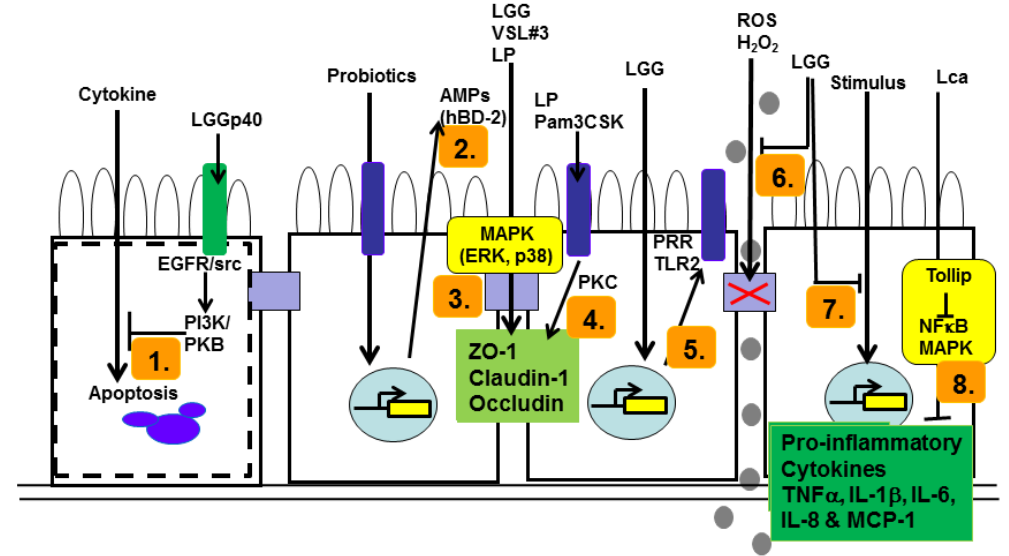
Figure 1. Probiotic modulation of intestinal epithelial cell signaling pathways Probiotic-mediated modulation of epithelial cell responses via activation or suppression of distinct signaling pathways is species ‐ dependent. Mechanisms of modulation are presented above for a range of species of Bifidobacteria, Lactobacilli, Streptococcus, VSL#3 mixture and the yeast S. cerevisiae , indicated in the luminal space above the square epithelial cells; additionally, LGG, L. rhamnosus strain GG; LGGp40, LGG secreted p40 protein; LP, L. plantarum ; Lca, L. casei . Mechanisms are indicated by numbers 1–8 in orange boxes: 1. Anti-apoptotic, 2. Antimicrobial defence, 3. Reinforcement of tight junction (TJ), 4. Reinforcement of TJ (gene expression & translocation to TJ), 5. Pathogen sensing, 6. Protection against TJ damage, 7. & 8. Suppression of inflammatory cytokines. Arrowed lines are activatory, blunted lines are suppressive/inbibitory. Light blue boxes between epithelial cells are representative of tight junctions. Dark blue boxes represent PRRs, predominantly TLR2. Dark green box on apical surface is an, as yet unidentified receptor for LGGp40. EGFR, Epithelial growth factor receptor; Src, serine-threonine kinase; ZO-1, zonula occludens-1; AMPs, antimicrobial peptides; TNF α , tumour necrosis factor-alpha; PRR, pattern recognition receptors; PKC, protein kinase C; PI3K, phosphatidyl inositol 3 ‐ kinase.